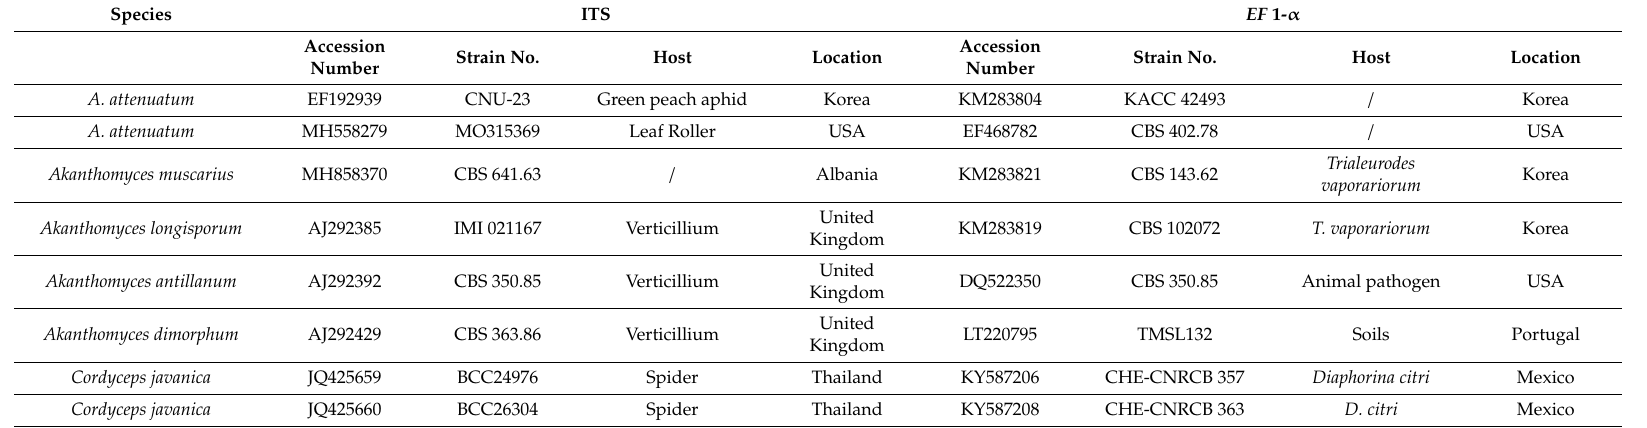
Table 2. Reference entomopathogenic fungi from GeneBank used for the phylogenetic analysis. Species ITS Strain No. Strain